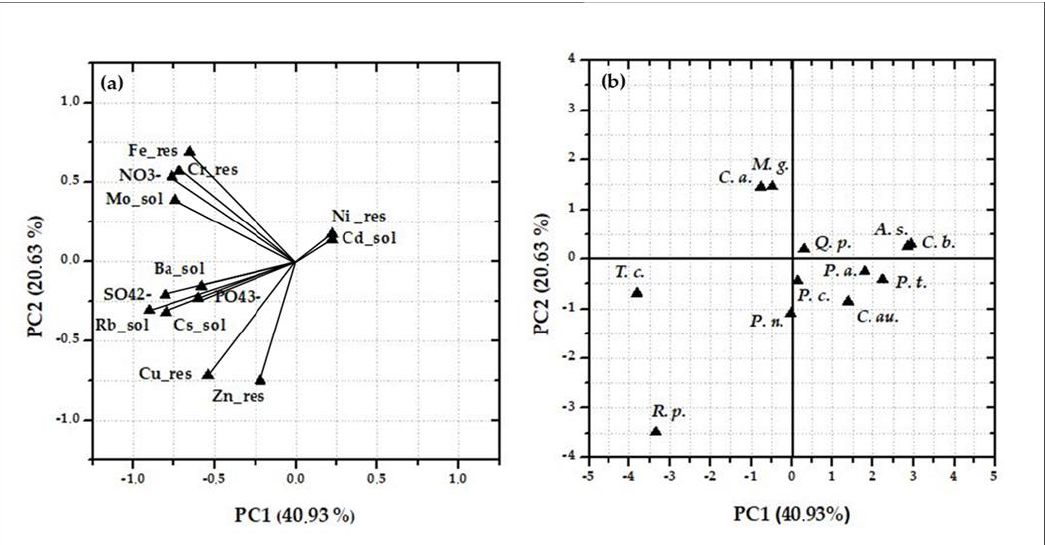
Figure 6. Biplots of the factor coordinates ( a ) and of factor scores ( b ) of the first principal components (PCs) obtained by correlation-based principal component analysis (PCA) of the concentrations per unit leaf area in the water-soluble fraction of Ba, Cd, Cs, Mo, Rb, NO 32 − , SO 42 − , PO 43 − and in the insoluble fraction of Cr, Cu, Fe, Ni and Zn, as obtained by the twelve tree species sampled in the urban park in Terni. Tree species are: Acer saccharinum ( A. c. ), Catalpa bignonioides ( C. p. ), Cedrus atlantica ( C. a .), Celtis australis ( C. au. ), Magnolia grandiflora ( M. g. ), Platanus acerifolia ( P. a. ), Populus nigra ( P. n. ), Populus tremula ( P. t. ), Prunus cerasifera ( P. c. ), Quercus pubescens ( Q. p ), Robinia pseudoacacia ( R. p. ) and Tilia cordata ( T. c. ).